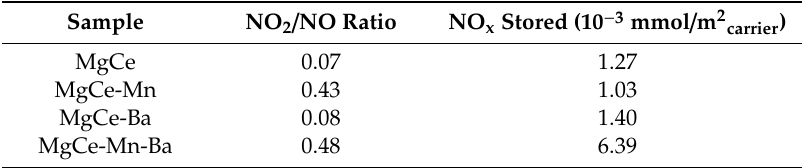
Table 5. NO 2 / NO ratios and amounts of NO x stored on the di ff erent samples obtained under single-bed